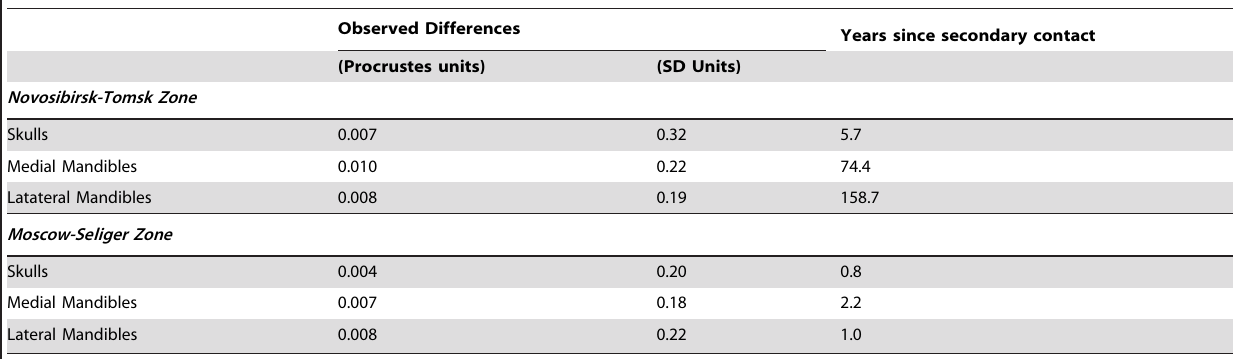
Table 2. Estimates related to the age of the hybrid